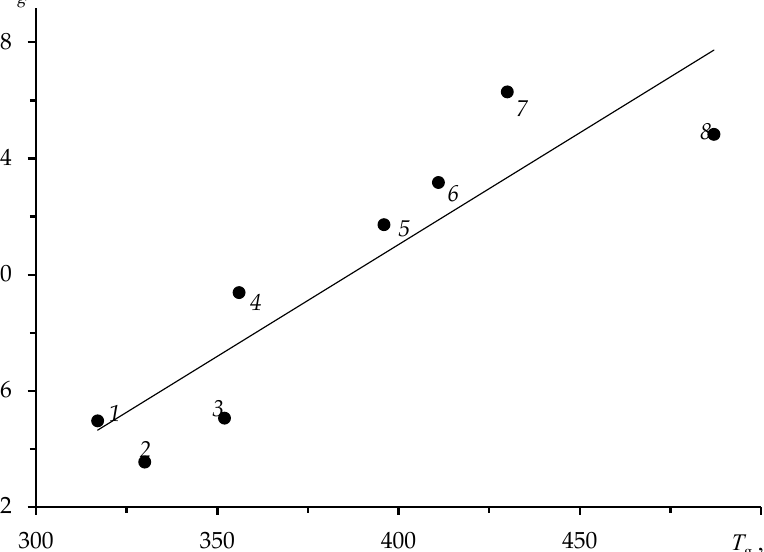
Figure 3. Linear correlation between δ T g and T g for Se ‐ Ge glasses. The point numbers correspond to the glass order numbers in Table 1.